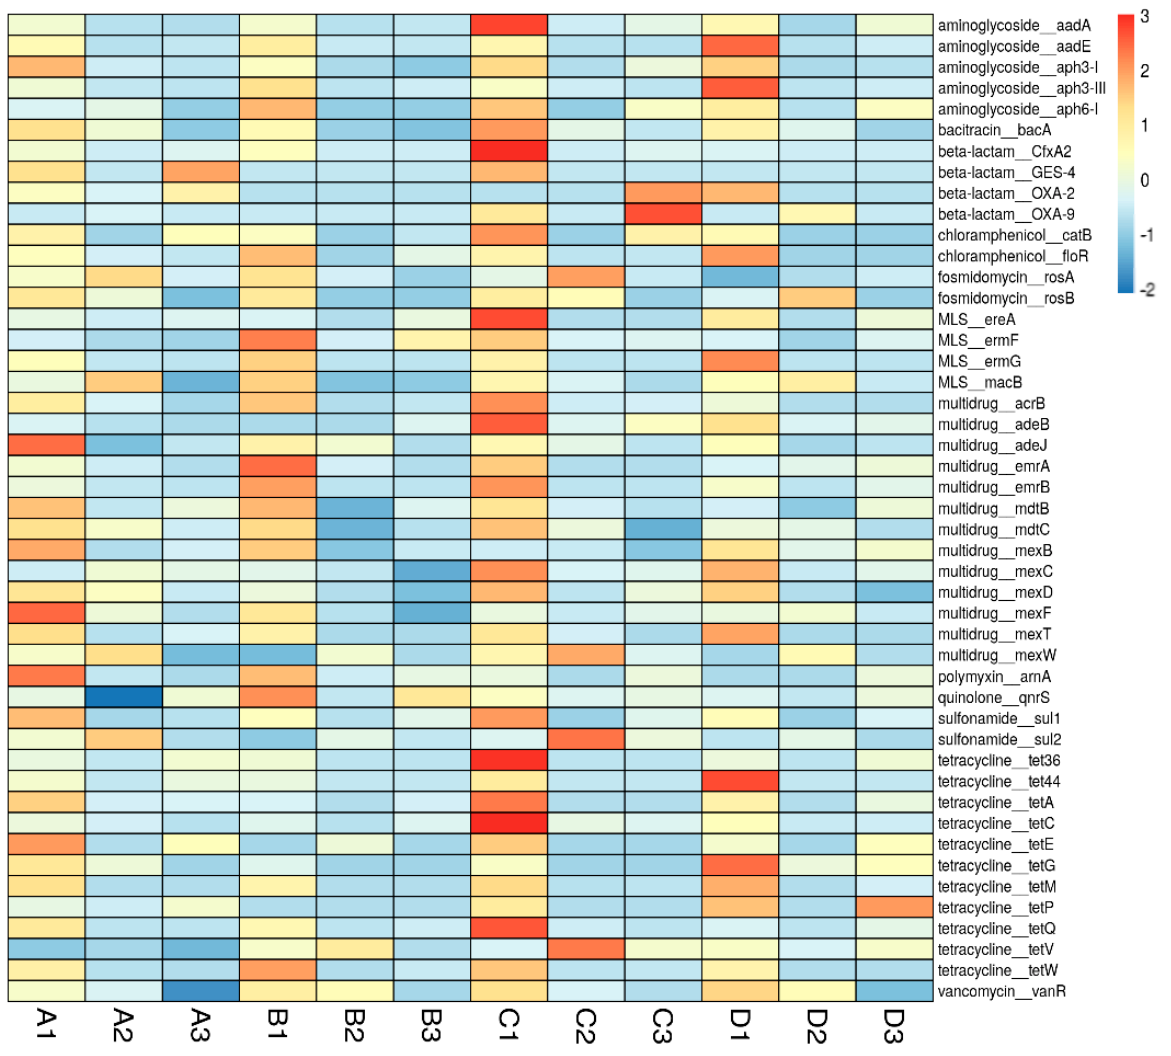
Figure 2. Heatmap of the relative abundance of ARG subtypes (top 50 most abundant) in the small (A, B) and large (C, D) WWTP samples. A1, B1, and C1 indicate influent samples, A2, B2, and C2 indicate activated sludge samples, and A3, B3, C3 indicate effluent samples.